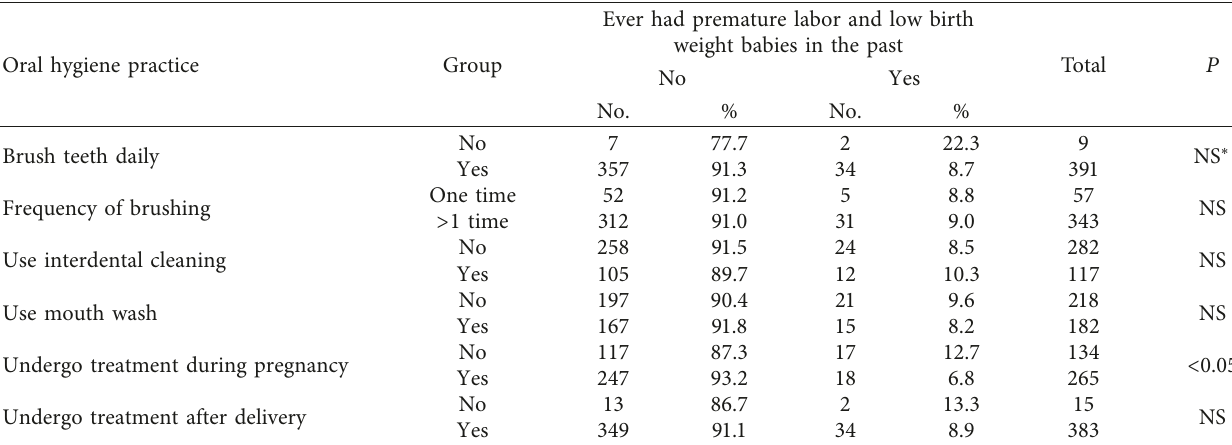
Table 3: Association between oral hygiene practice and history of premature labor and low birth weight babies in the past ( N � 400).